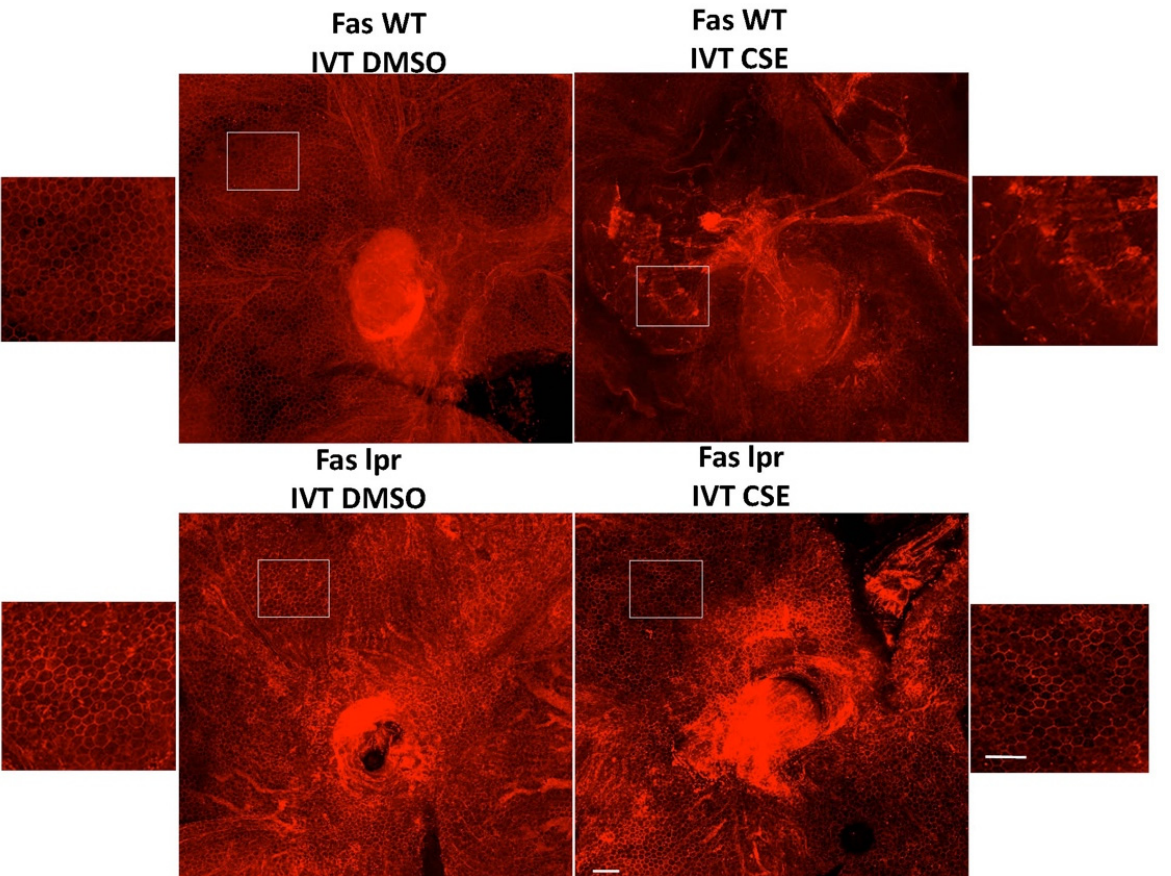
Figure 2. Fas deficiency protects the RPE from cigarette smoke extract-induced cell death. Wild-type control (Fas WT) or Fas-deficient lpr (Fas lpr) mice ( n = 5 each) were given intravitreal CSE (250 µg/mL) in one eye or DMSO vehicle in the contralateral eye. After 10 days, RPE flatmounts were immunolabeled for ZO-1 to outline cell shape. The RPE of the wild-type mice given vehicle had preserved cobblestone morphology ( top left ), while the RPE of wild-type mice given CSE had disrupted ZO-1 labeling with ill-defined cell shape and enlarged, irregular contour ( top right ). In contrast, the RPE of lpr mice given either vehicle ( bottom left ) or CSE ( bottom right ) had regular cobblestone cell shape. Insets show magnified view of the RPE. Bar = 50 µm.